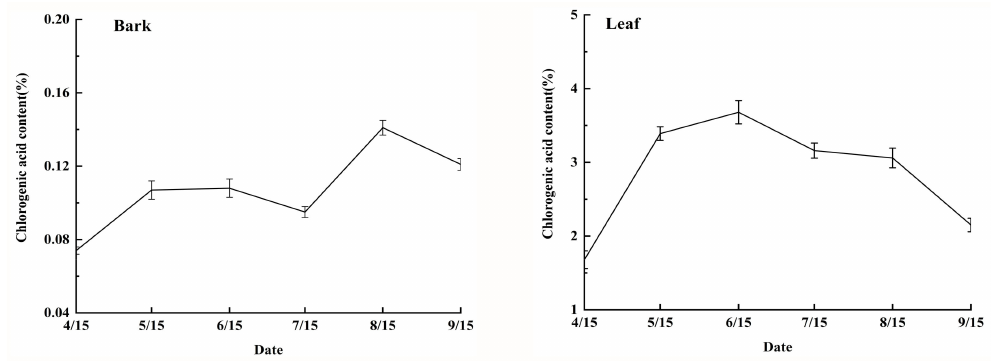
Figure 9. Changes of chlorogenic acid content in different developmental stages.